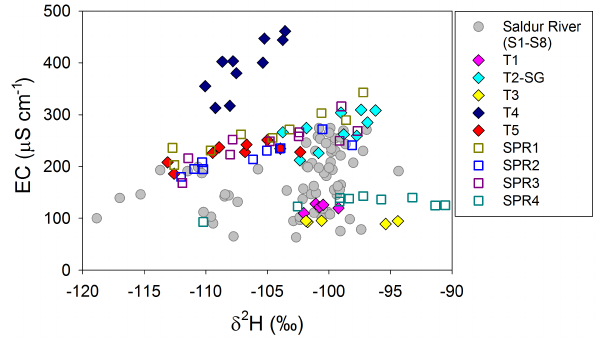
Figure 4. Relation between δ 2 H and EC at all locations in the main stream, the tributaries and the springs in 2011 and 2012. Data refer to samples collected at each location on the same days except for T1 and T3, where samples were taken for 1 year only (cf. Table